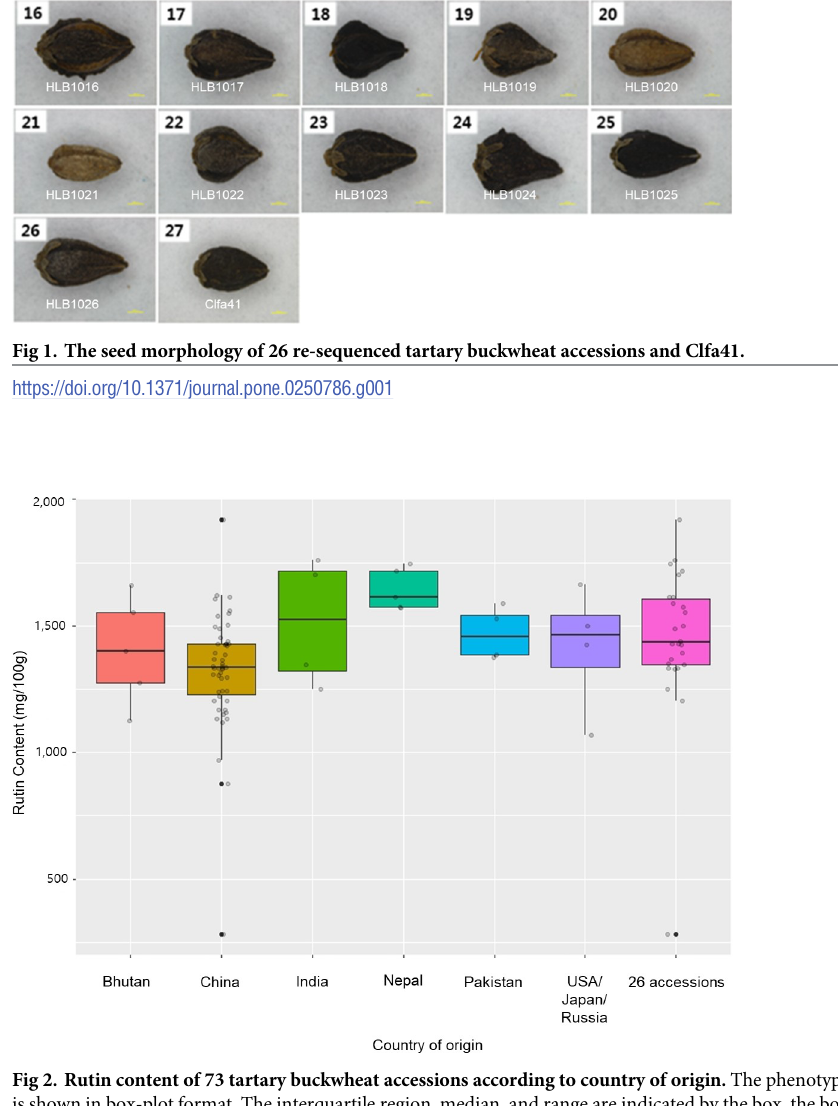
PLOS ONE | https://doi.org/10.1371/journal.pone.0250786 June 3,